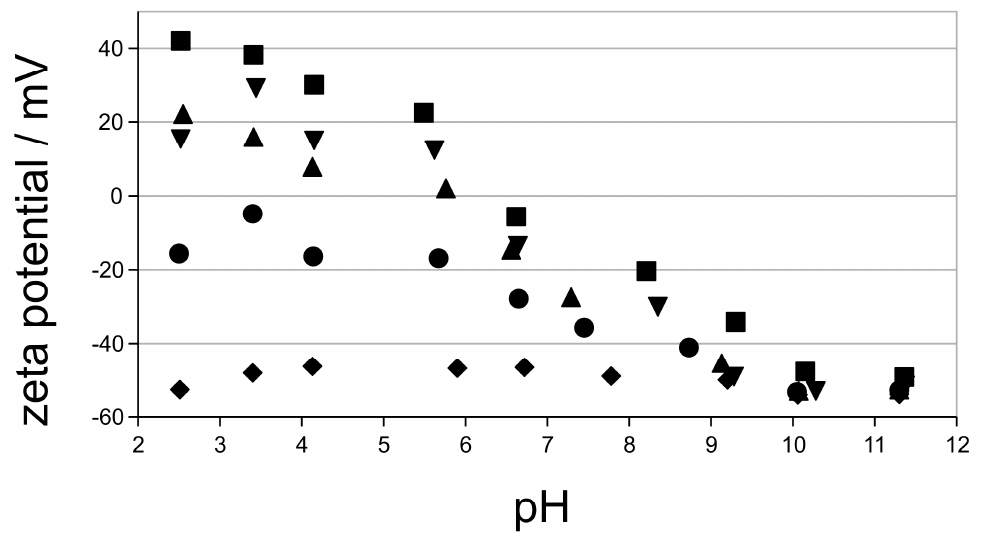
Figure 2. The zeta potentials of titania in 10 − 2 M NaCl at various concentrations of sodium octadecyl sulfate in 5% ethanol. ■ 0, ▼ 3.2 × 10 − 6 , ▲ 5.4 × 10 − 6 , ● 1.1 × ∙ 10 − 5 , ♦ 2.1 × ∙ 10 − 5 M sodium octadecyl sulfate.